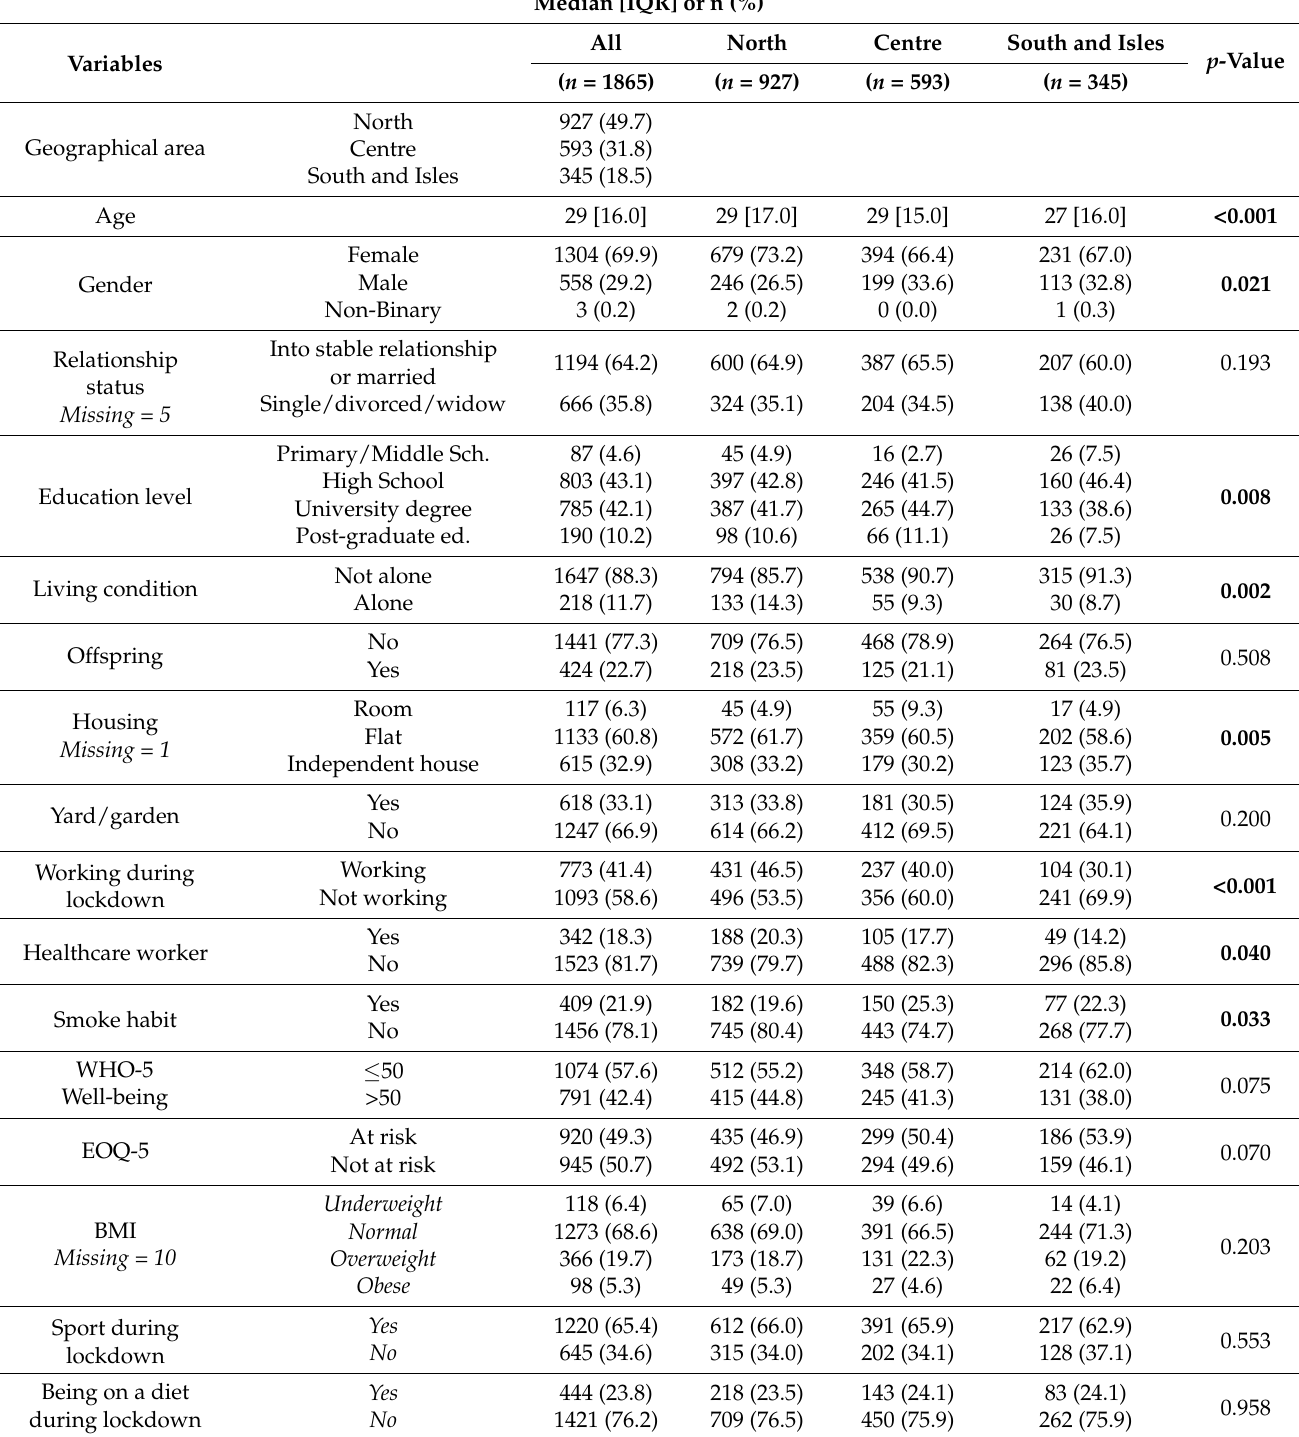
Table 1. Participant characteristics stratified by geographical area: Descriptive and Chi-square